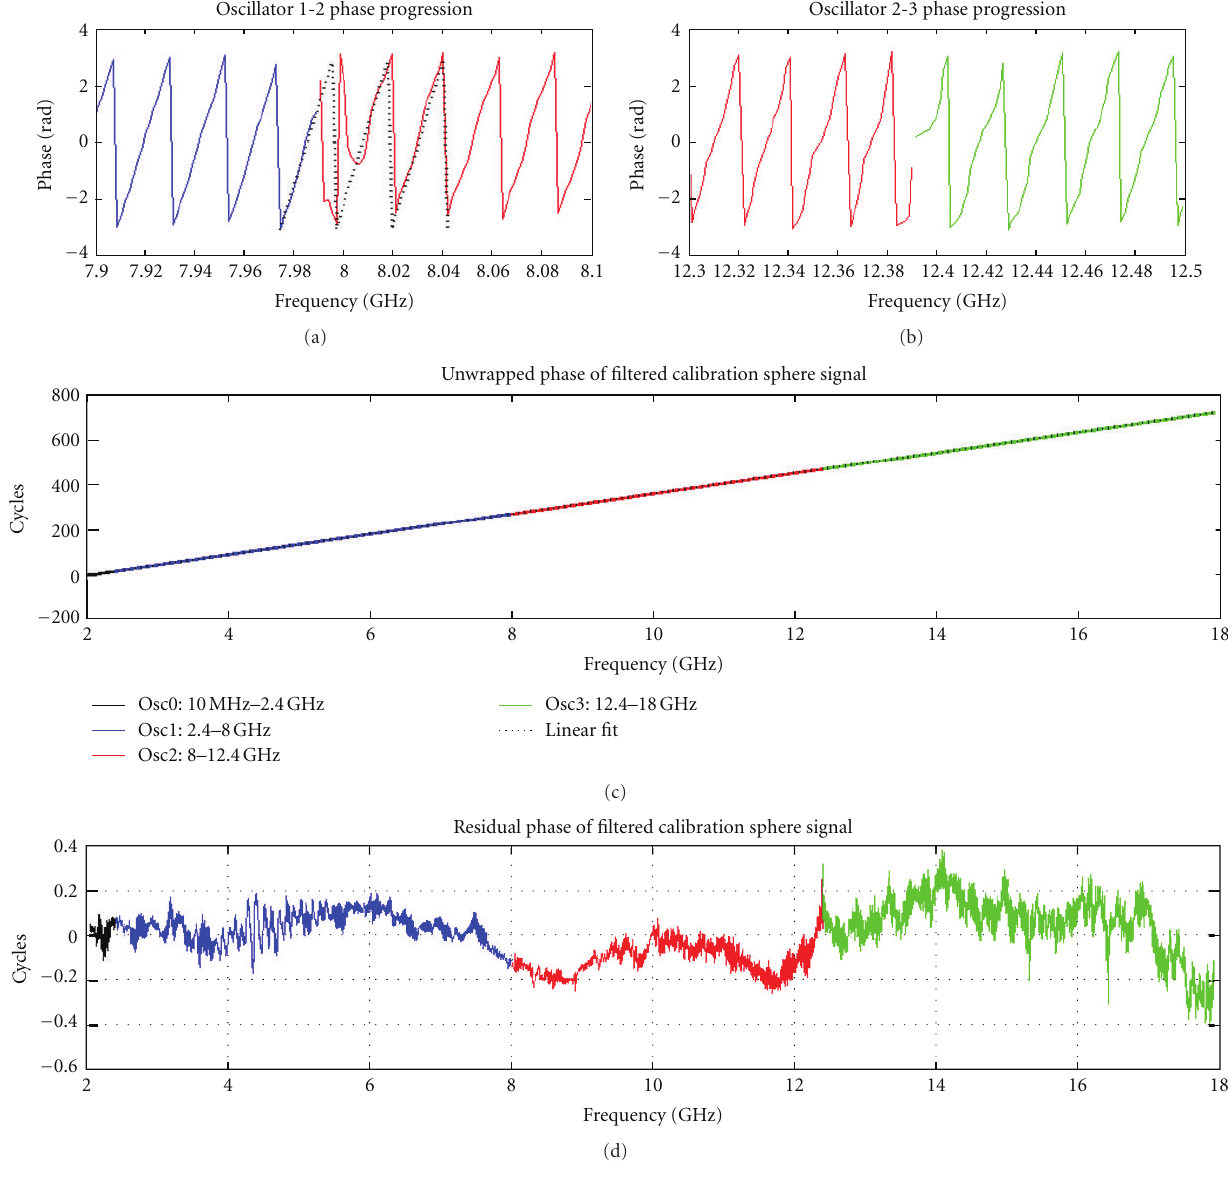
Figure 7: Determination of LFM-CW system non-linearity using phase fill-in and unwrapping applied to an isolated target.